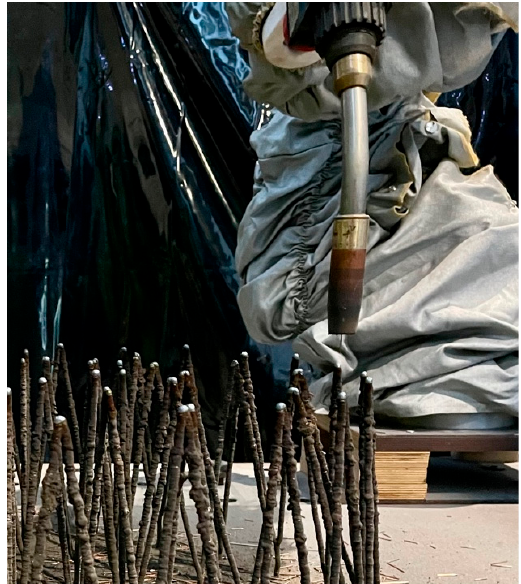
Figure 6. Printing process of a WAAM lattice structure. Table 3. SC3DP process parameters.